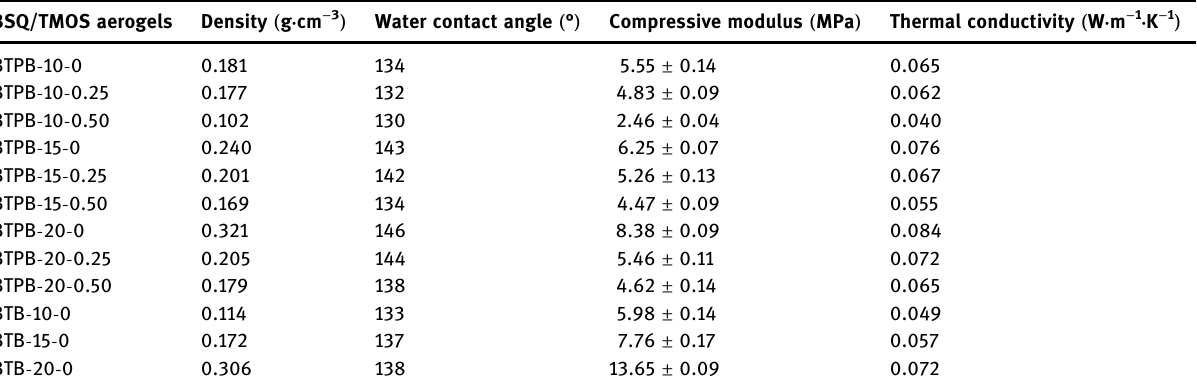
Table 2: Density, water contact, compressive modulus, and thermal conductivity of BPSQ aerogels BSQ/TMOS